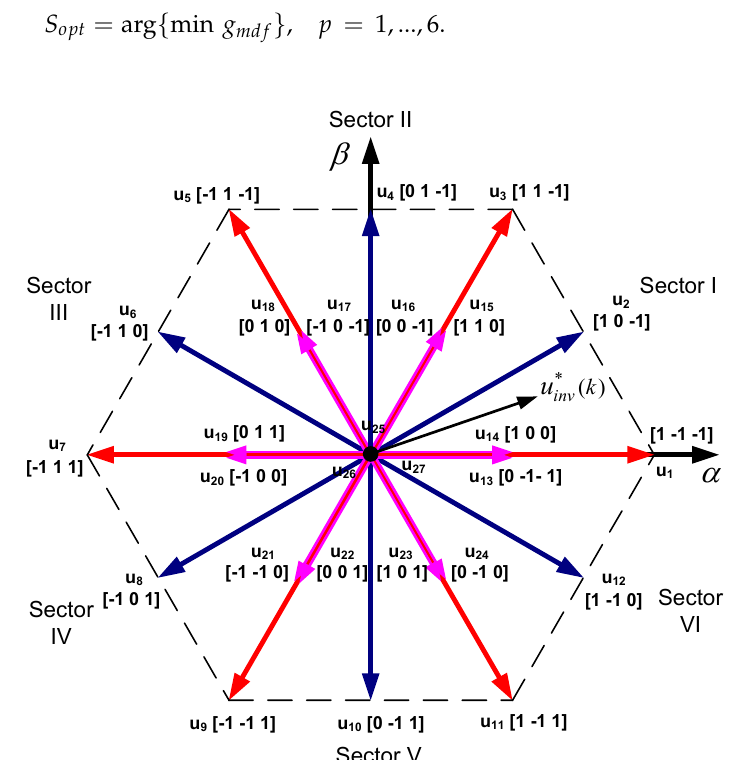
Figure 2. Voltage vectors distribution of T-type inverter.